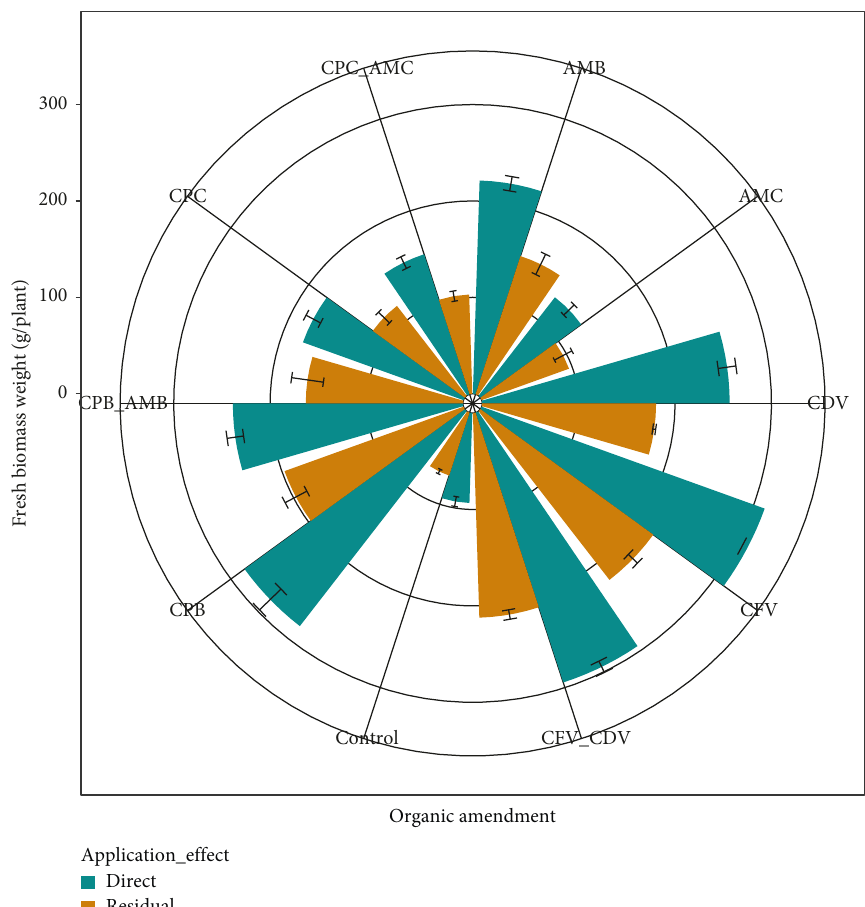
Figure 8: Response of fresh biomass weight to direct and residual effects of organic